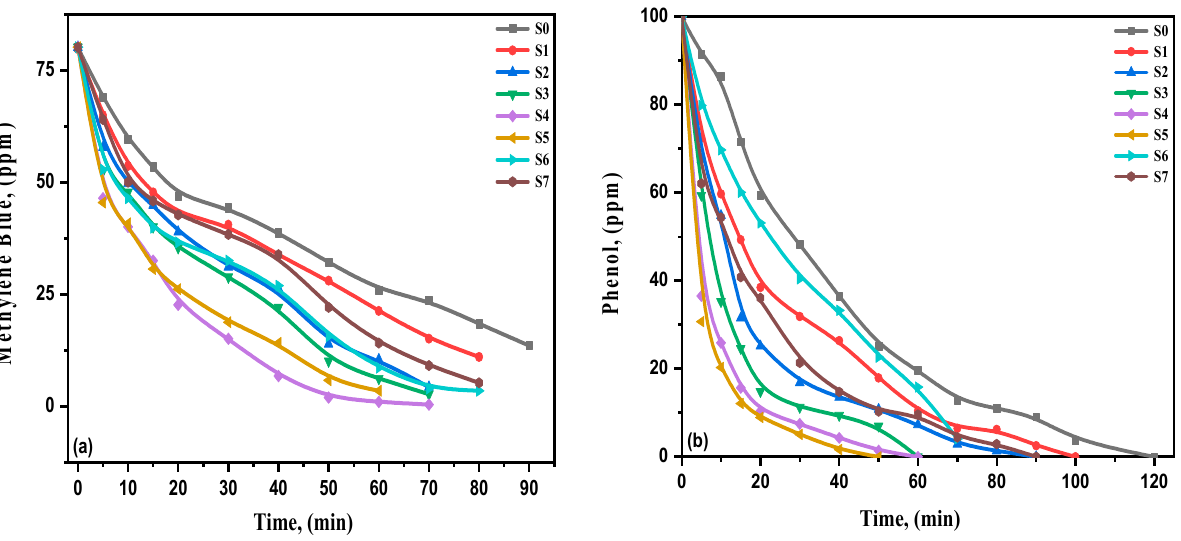
Figure 7. ( a , b ) Concentration versus time for photodegradation using Eu 2 O 3 -ZnO of: ( a ) MB; ( b ) phenol.